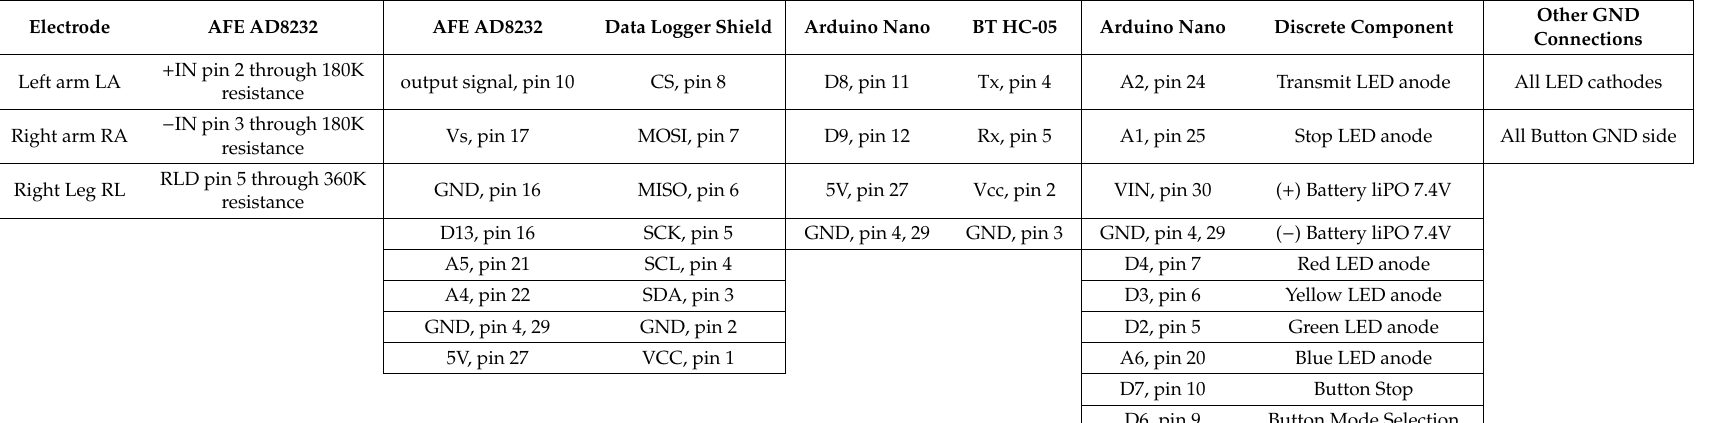
Table 2. Tracing the connections for the ECG prototype